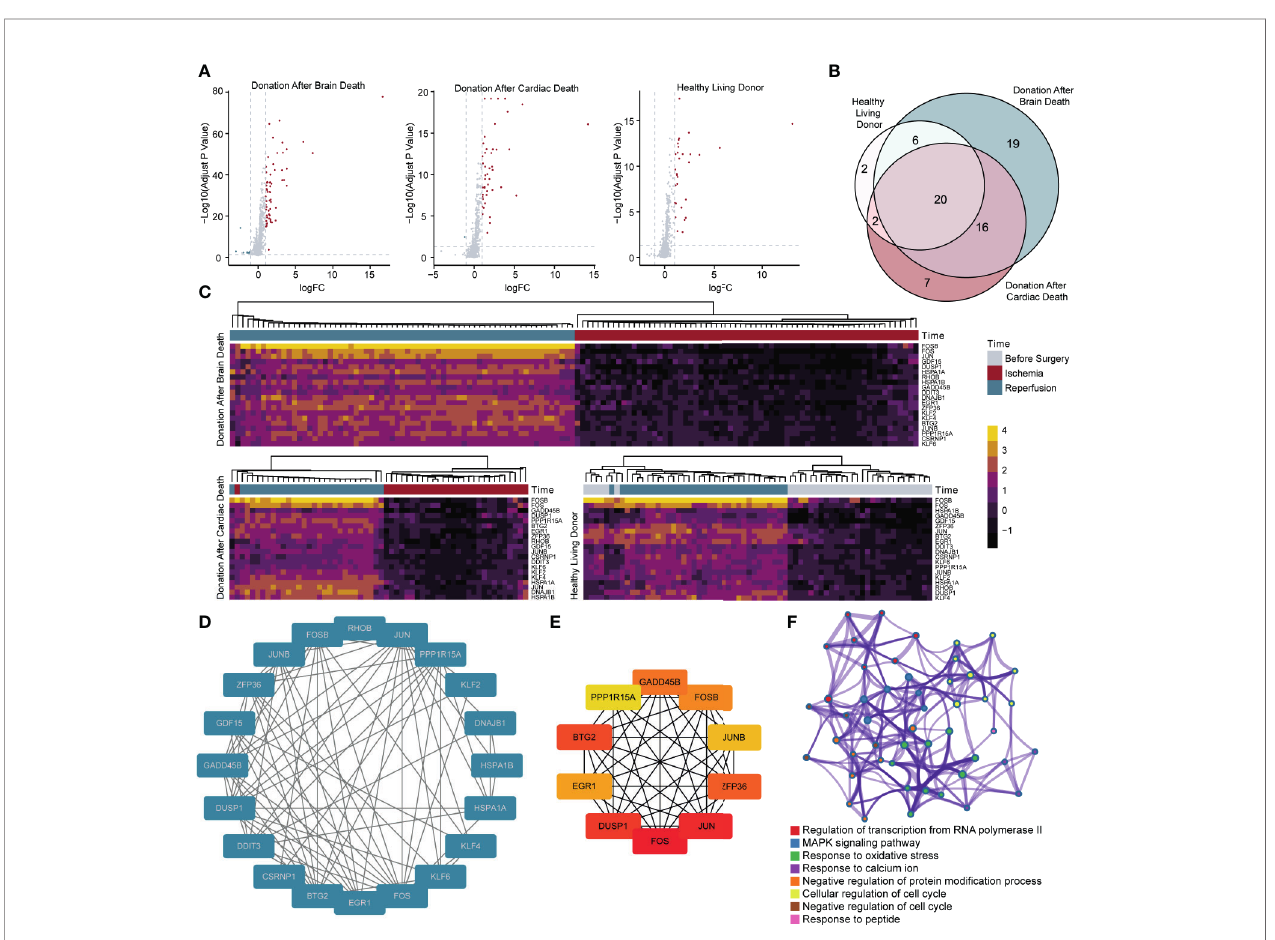
FIGURE 2 | Screening and analysis of DEGs for RIRI. (A) Volcano plots show DEGs between samples taken before and after reperfusion in brain death (61 upregulated and 9 downregulated genes), cardiac death (45 upregulated and 1 downregulated genes), and healthy living donors (30 upregulated genes), respectively. (B) The Venn diagram demonstrates the intersection of DEGs among three kinds of donor types. (C) Clustering heat maps illustrate expression levels of 20 robust DEGs in different phases of renal transplantation. Protein – protein interaction network of 20 DEGs (D) and 10 hub genes (E) . The deeper color indicates higher connectivity. (F) Network of enriched clusters, where each node represents one statistically signi fi cant term of biological process, and terms with similarity of more than 0.3 are connected by edges. DEGs, differentially expressed